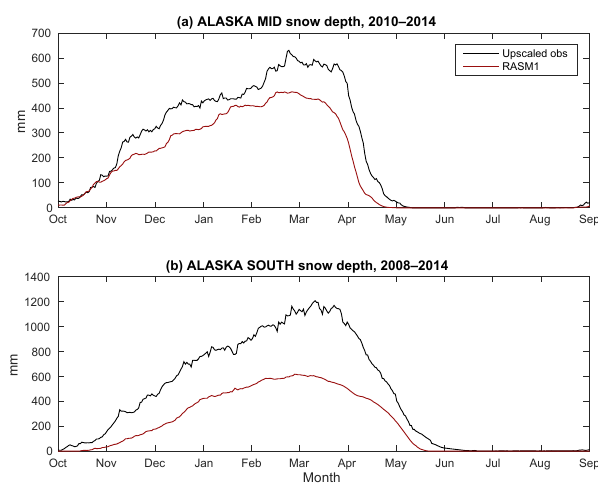
Figure 12. The mean annual cycle over a water year (October– September) of snow depth averaged for the 2 ◦ × 2 ◦ boxes defined in Fig. 1 for (a) the middle of Alaska (ALASKA MID) and (b) south- ern Alaska (ALASKA SOUTH) as in upscaled observations (black) and in RASM1